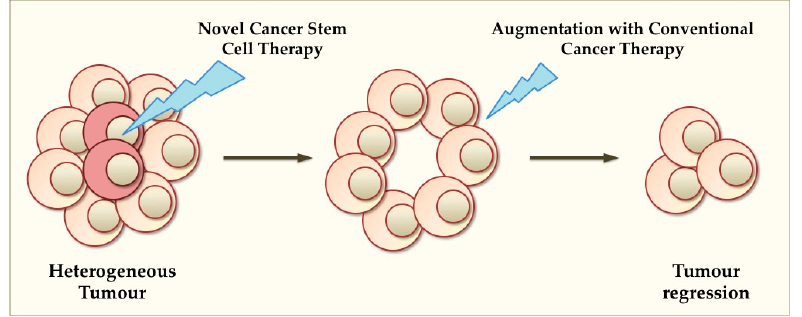
Figure 3. Potential of novel CSC-targeted therapies. According to the CSC theory, brain and breast tumours harbour a population of CSCs, which are refractory to current conventional therapy. Specifically targeting CSCs via silencing pluripotency oncogenes may eliminate CSCs and augment conventional therapies, resulting in tumour regression.